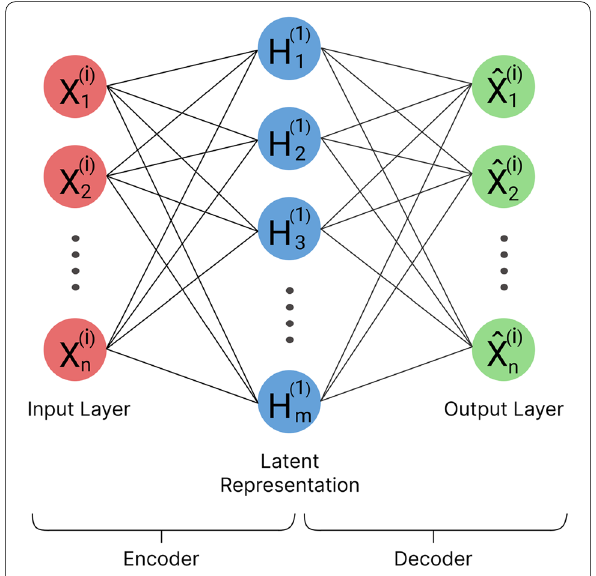
Fig. 1 The architecture of a sample